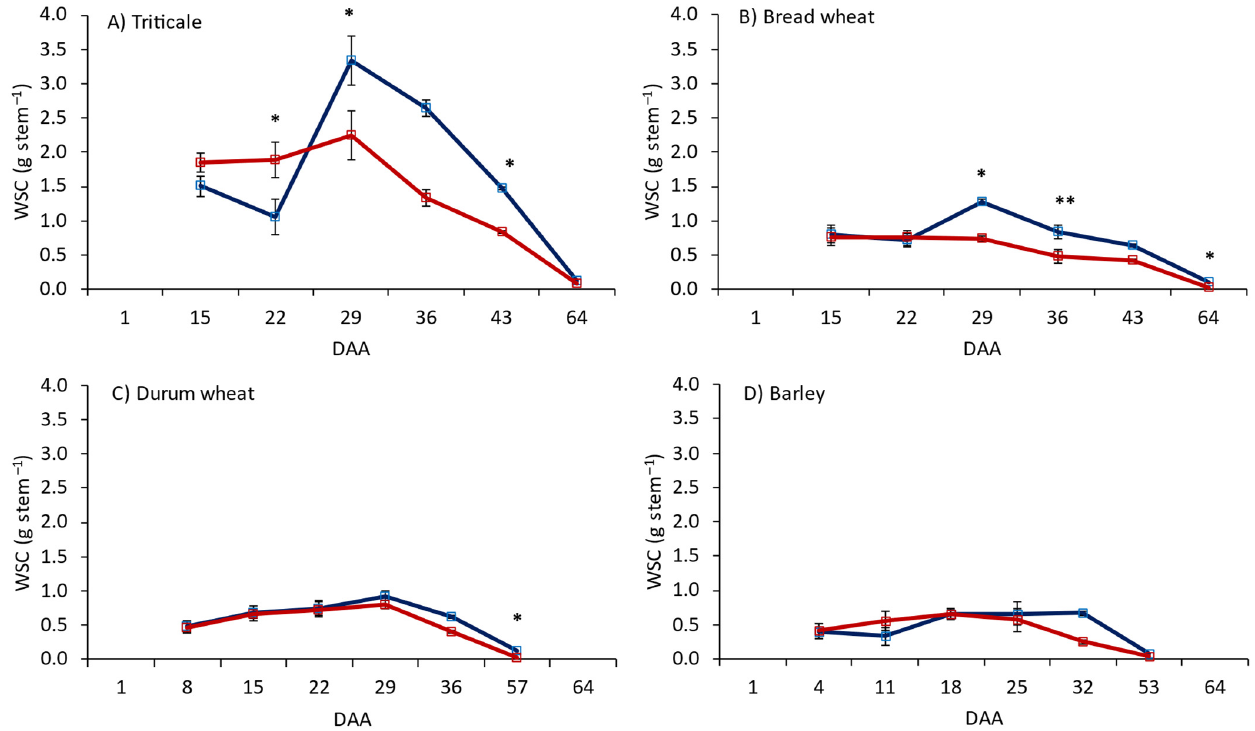
Figure 5. Time variation (expressed as days after anthesis, DAA) of water-soluble carbohydrate (WSC) content in stems during the grain filling period in ( A ) triticale, ( B ) bread wheat, ( C ) durum wheat, and ( D ) barley under well-watered (WW) and water-limited (WL) regimes. Statistical differences ( p < 0.05 *; p < 0.01 **) between water regimes.